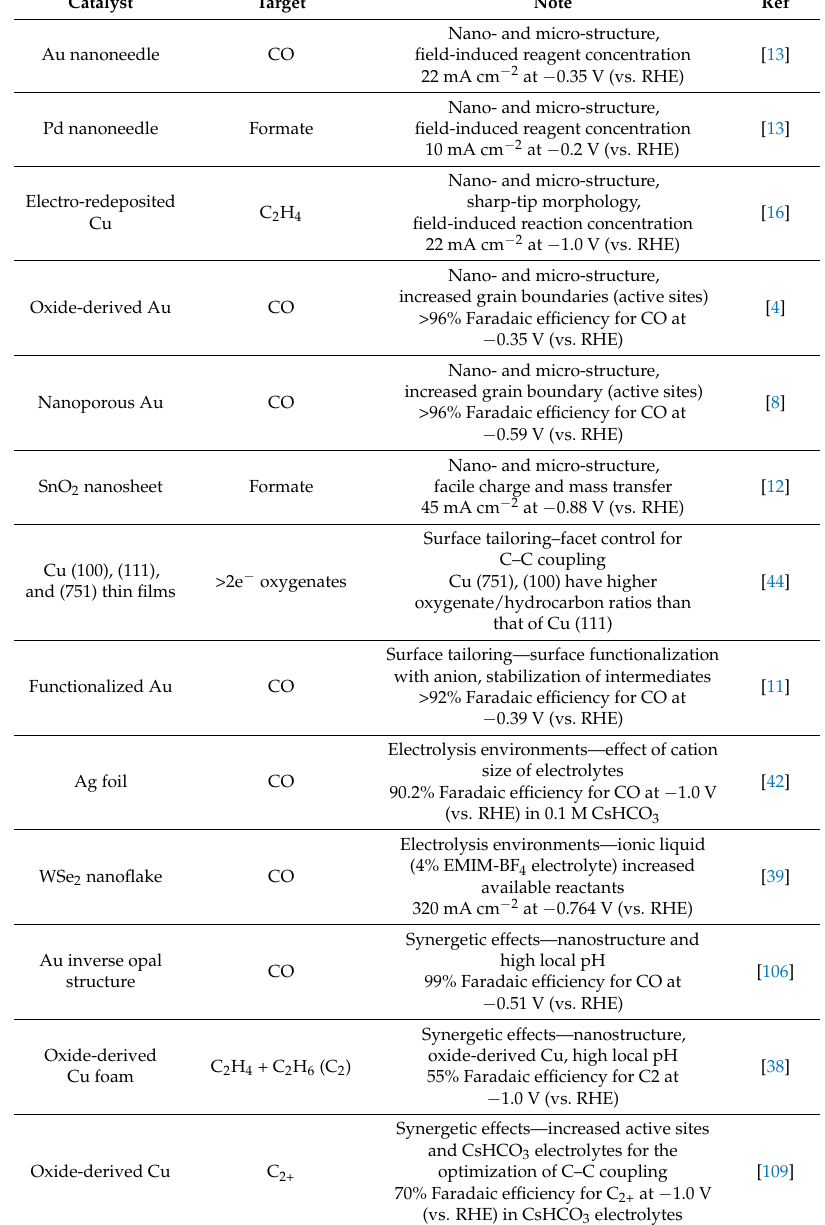
Representative catalysts and their CO 2 reduction reaction (CO 2 RR)